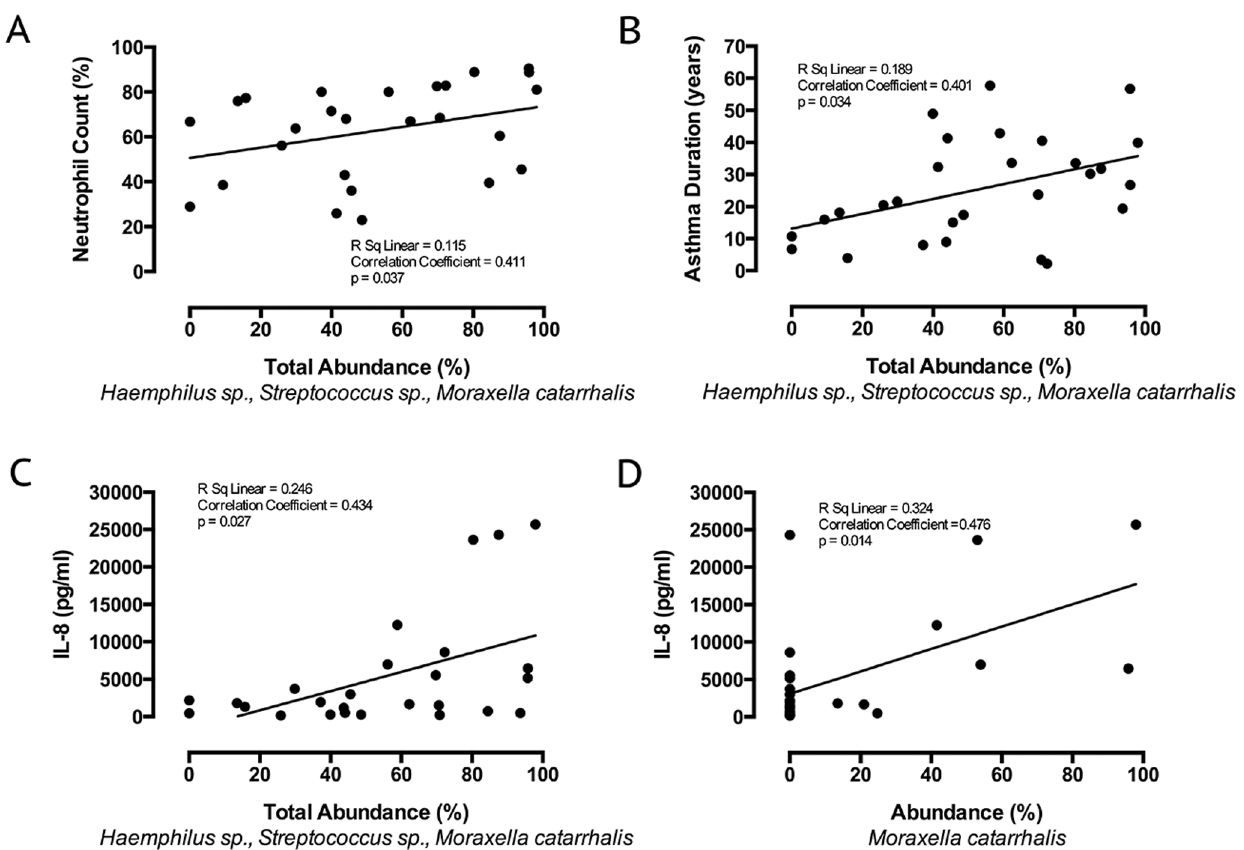
Figure 1. Severe asthma disease duration and inflammation related to abundance of Haemophilus.,Streptococcus , and Moraxellasp. The relationship in treatment-resistant severe asthma between total abundance of Haemophilus sp., Streptococcus sp. , and Moraxella catarrhalis in